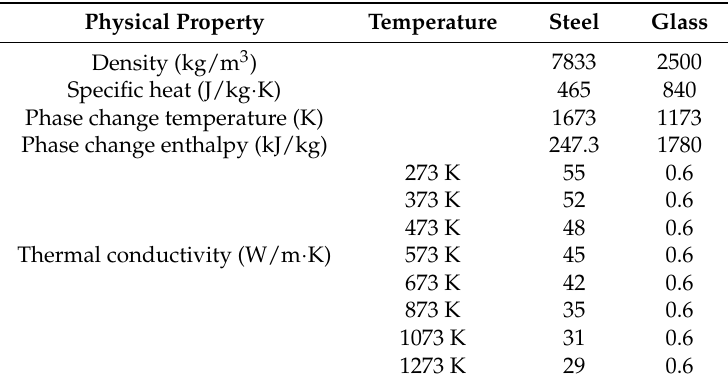
Table 2. Physical properties for steel (0.5% carbon) and glass as